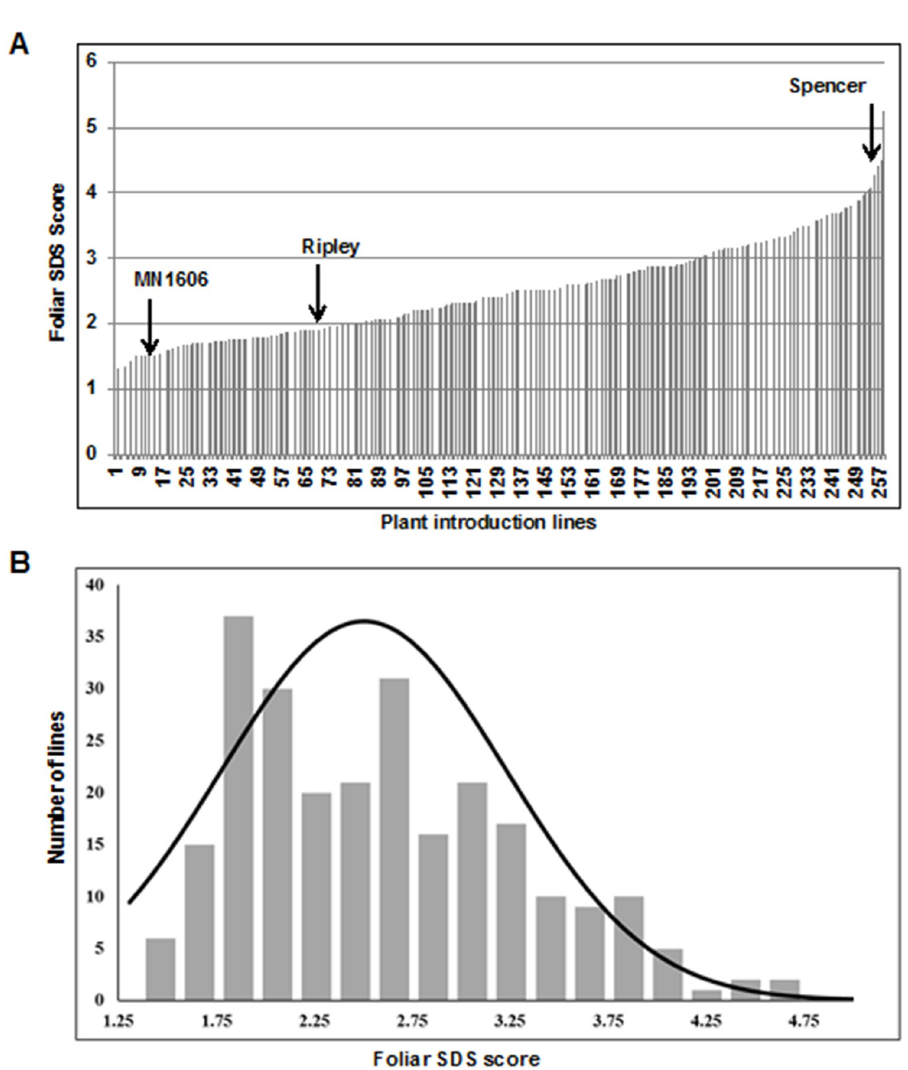
Fig 1. Foliar responses of 254 PI lines to F . virguliforme . (A) The foliar disease symptoms were scored 35 days following infection with F . virguliforme . Arrows indicate the disease scores of the SDS resistant cultivars, MN1606 and Ripley, and susceptible cultivar, Spencer. Phenotypic evaluation was conducted five times, each with three replications. The values are means of fifteen biological replications. (B) Distribution of foliar SDS scores among the 254 PI that are lines presented in